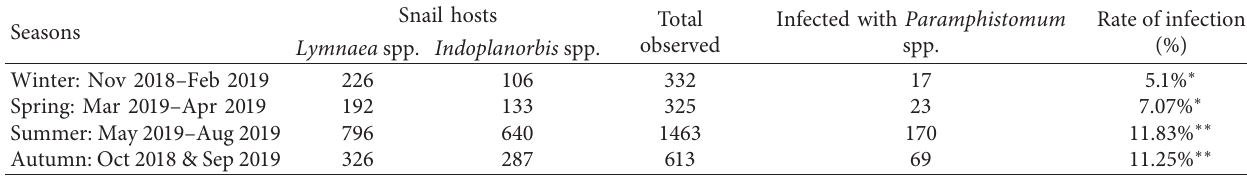
Table 3: Seasonwise prevalence of Paramphistomum spp . cercariae infection in Indoplanorbis and Lymnaea intermediate snail hosts in various districts of Khyber Pakhtunkhwa, Pakistan. Snail hosts Total Infected with Paramphistomum Seasons observed